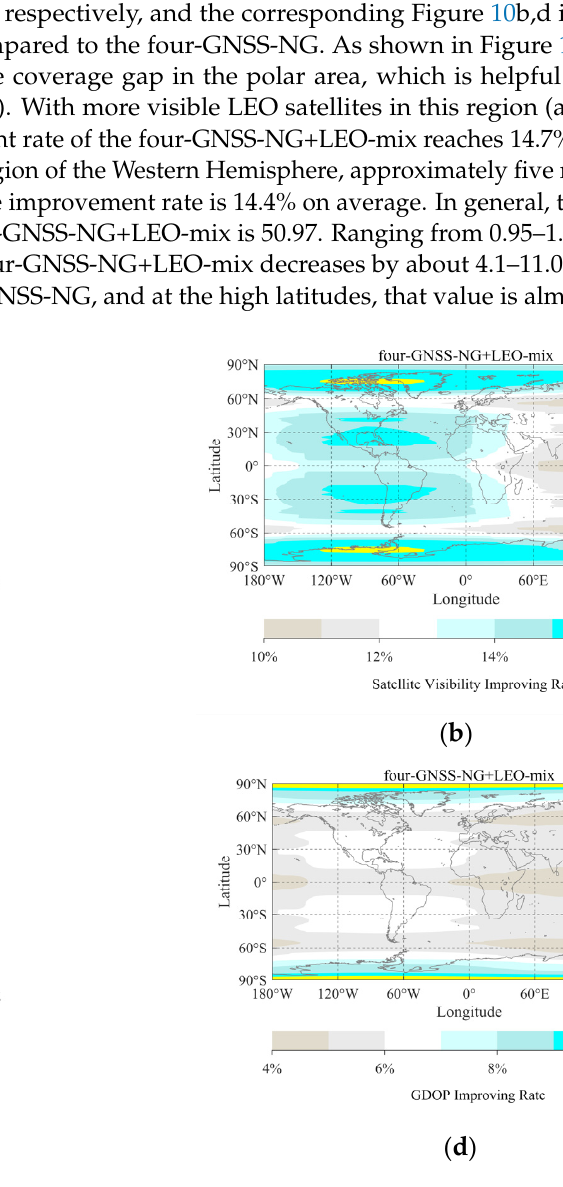
Figure 9. Coverage performance of six LEO constellations schemes.